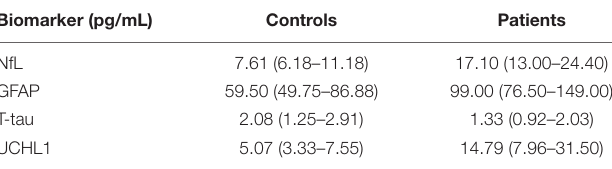
TABLE 3 | Intergroup comparison of plasma biomarker